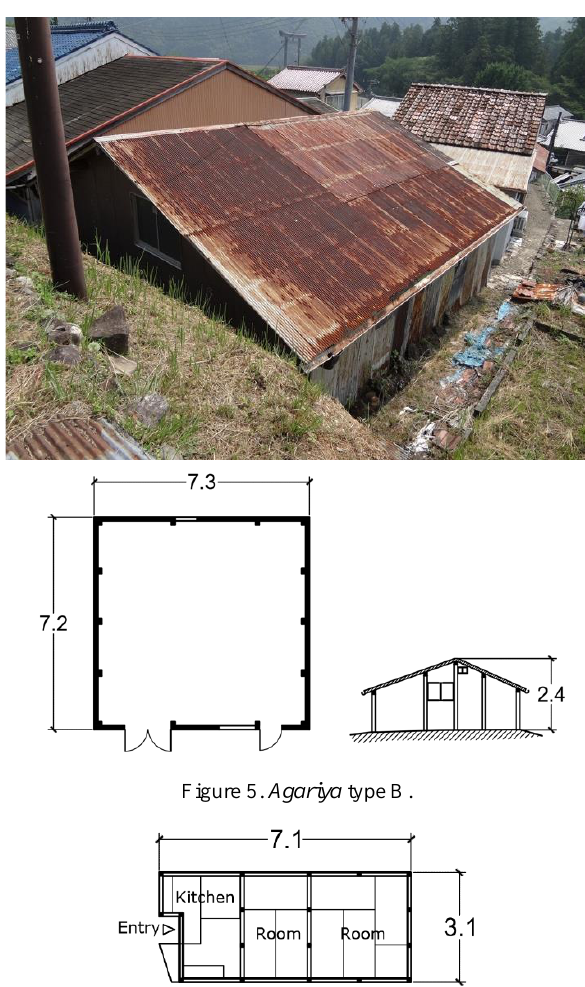
Figure 6. Agariya type C. Agariya of the Figure